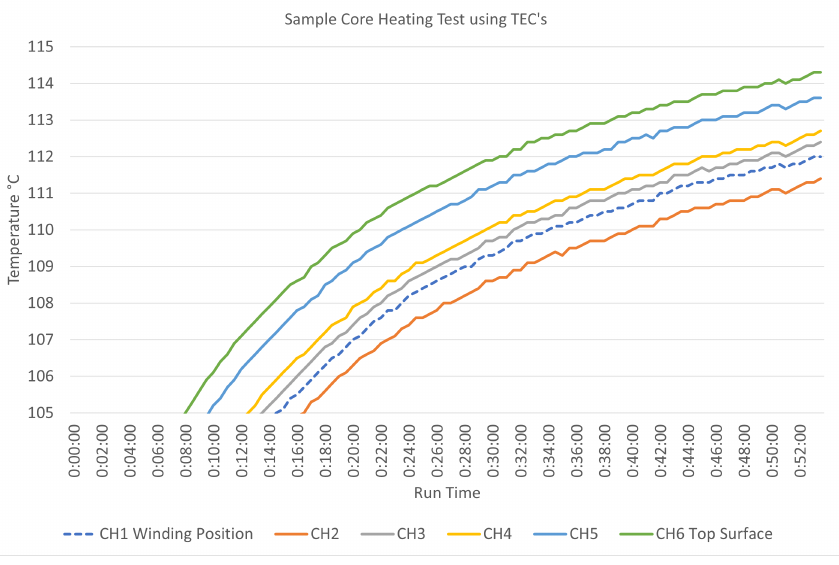
Figure 15. Zoomed final core temperature